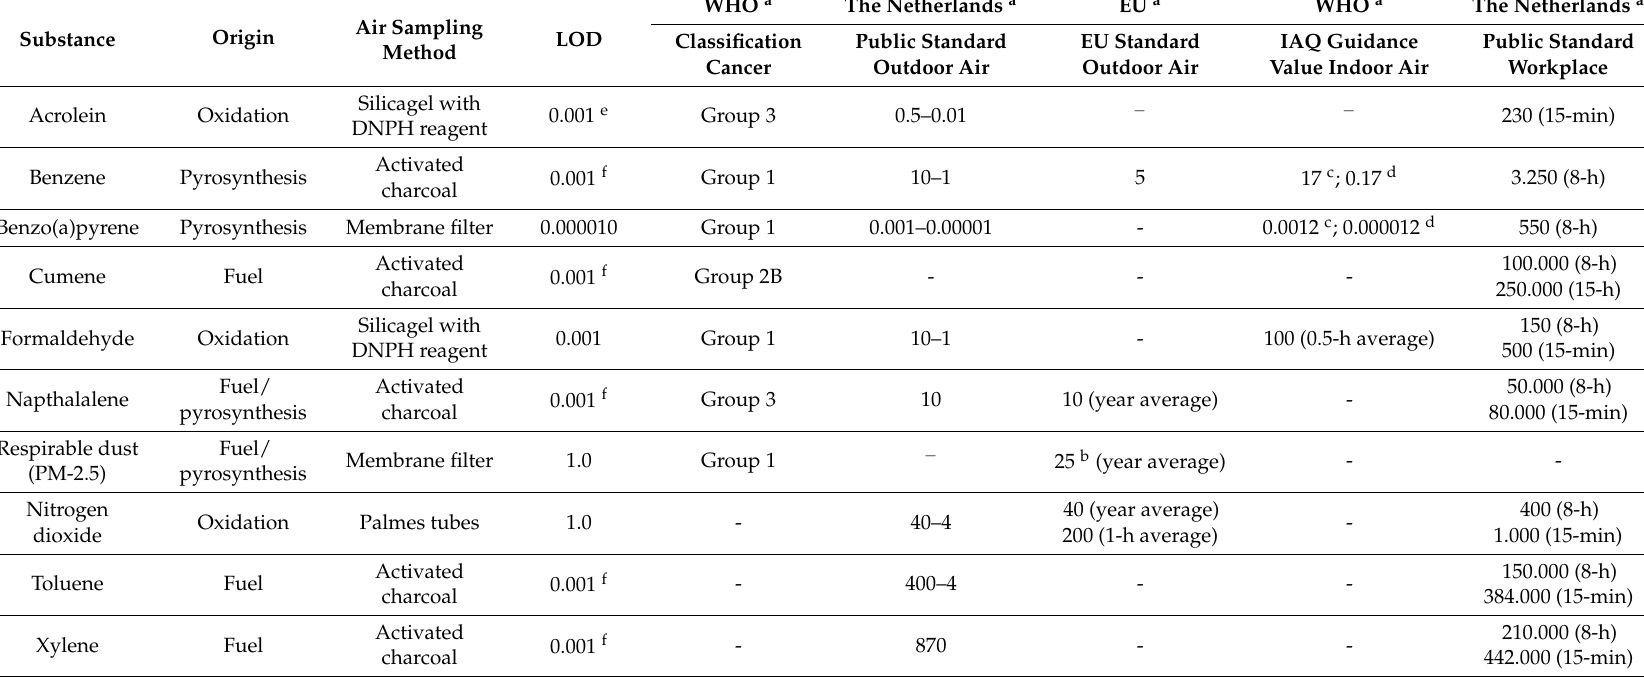
Table 1. Selected IAQ parameters, characteristics of measurement, hazard classification and available health-based air quality guidance (in µ g/m 3 ).